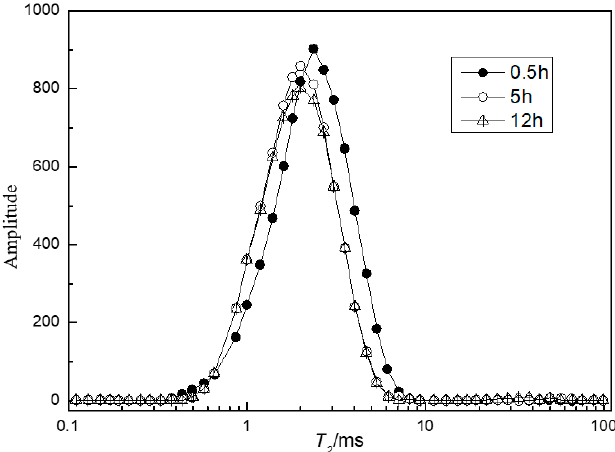
Figure 3. T 2 distribution of cement slurry with DMC content of 0%.